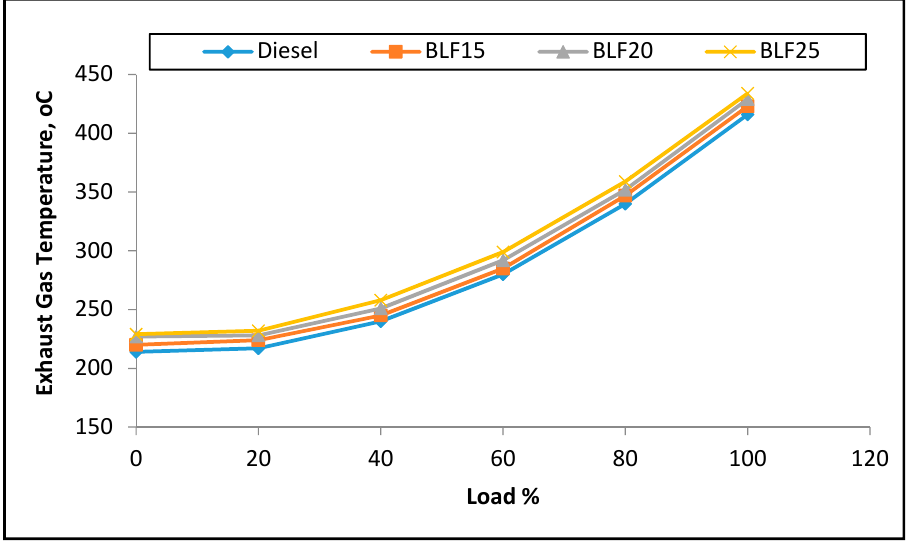
Figure 9. Variations of EGT vs. engine load percent.